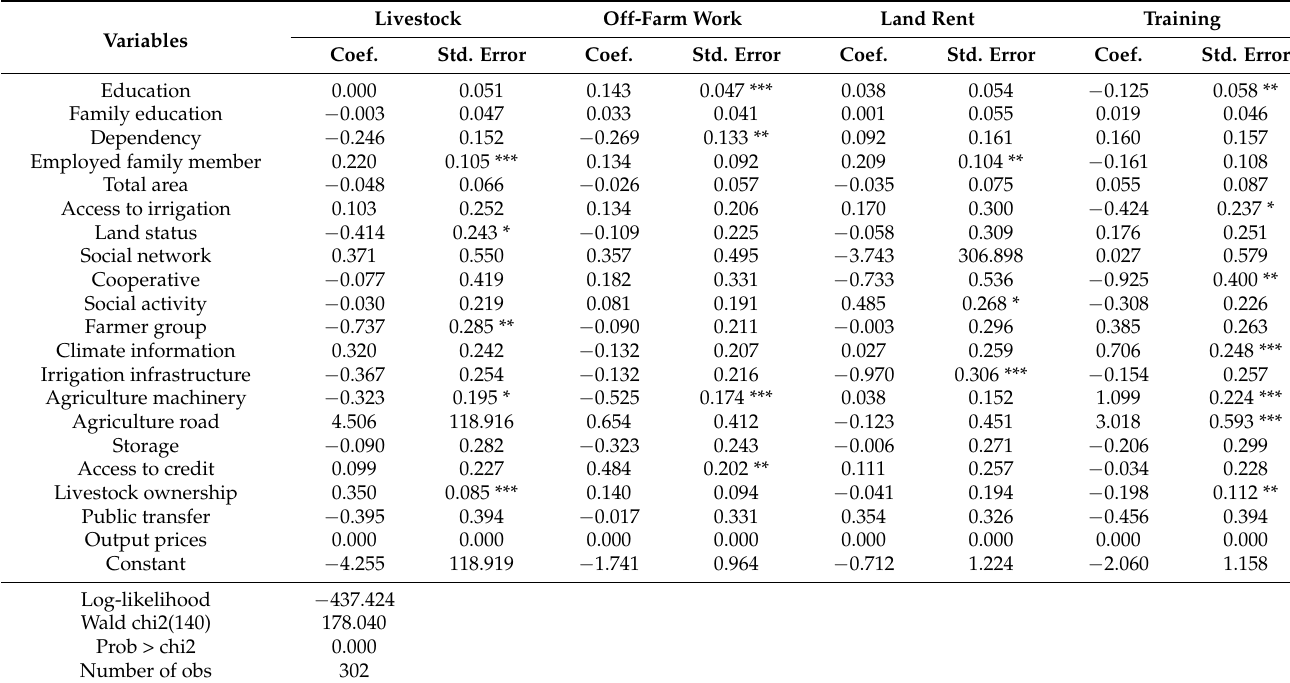
Table 2. The determinant of off-farm adaptation